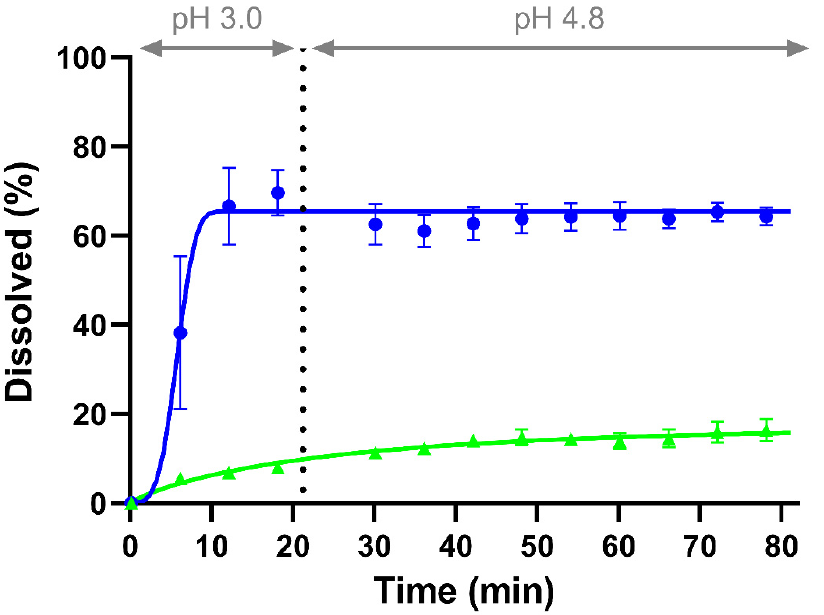
Figure 2. Monophasic dissolution experiment of CorA-povidone ( ● ) and CorA-copovidone ( ▲ ) under biorelevant conditions. Lines represent the Weibull fit. Table 4. Weibull parameters of CorA-povidone and CorA-copovidone, determined using the biorelevant monophasic dissolution setup.